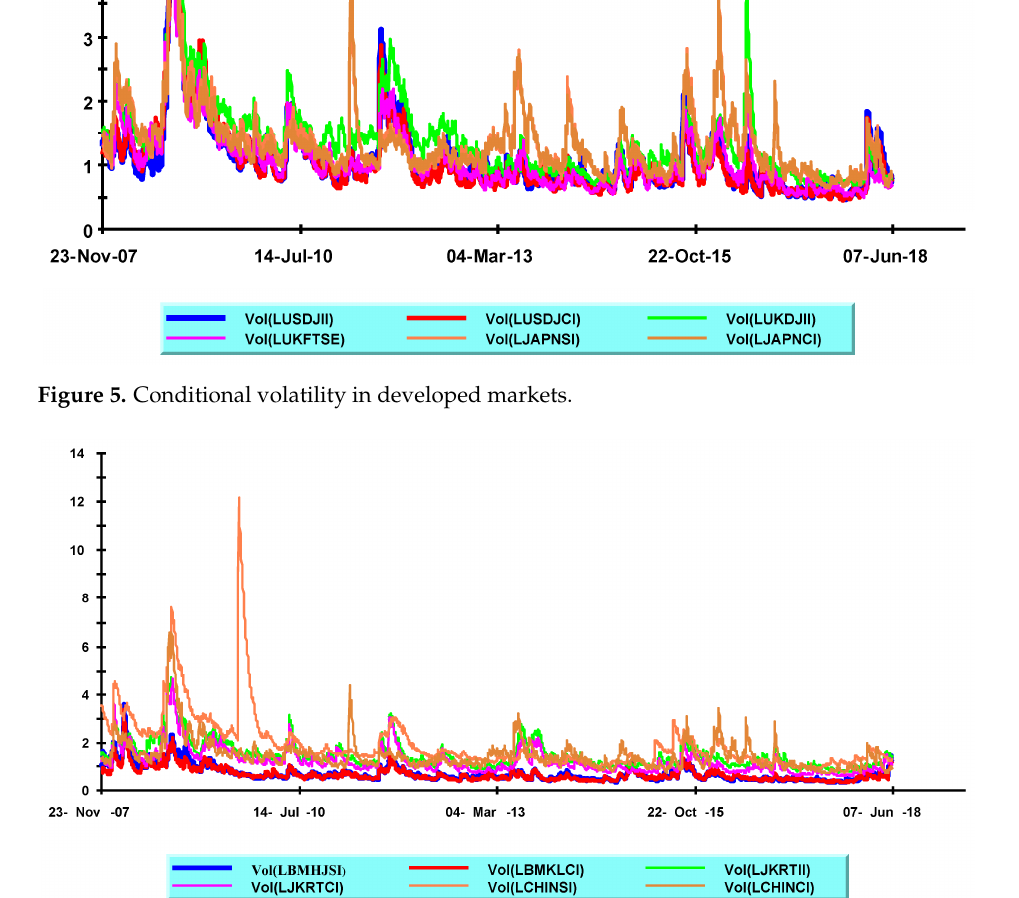
Table 5. Dynamic volatility and correlation analysis.